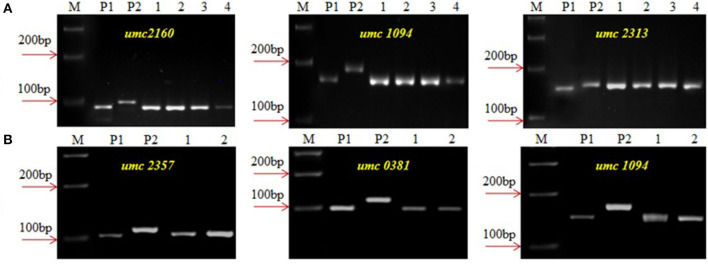
Background screening of improved lines using SSR markers. (A) UMI1200 × HP467-15, (B) UMI1230 × HP467-15, (M) Marker 100 bp, (P1) UMII1200/UMI1230, (P2) HP467-15, (1–4) Improved lines from UMI11200 × HP467-15 (1-UMI1200β+-1, 2-UMI1200β+-2, 3-UMI1200β+-3, 4-UMI1200β+-4, and (1 and 2) Improved lines from UMI1230 × HP467-15, (1-UMI1230β+-1, 2-UMI1230β+-2).